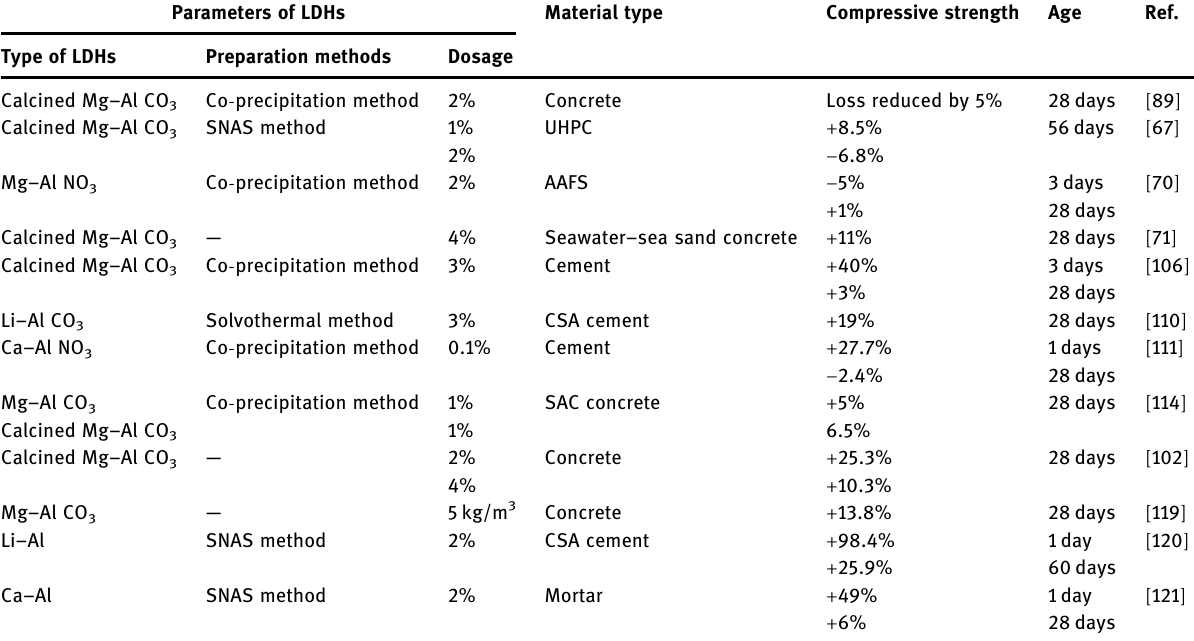
Table 1: E ff ect of LDHs on compressive strength of cement - based materials Parameters of